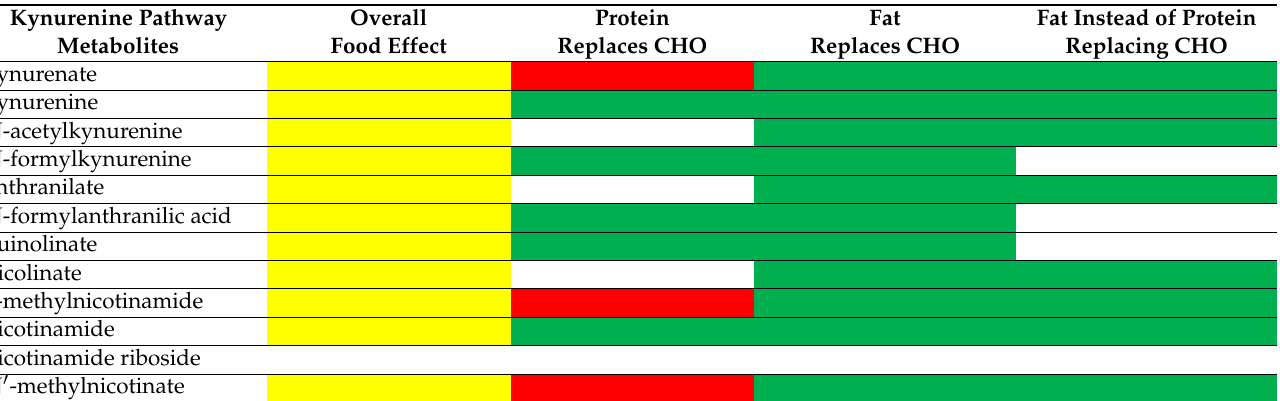
Table 5. Effects of foods on serum kynurenine pathway